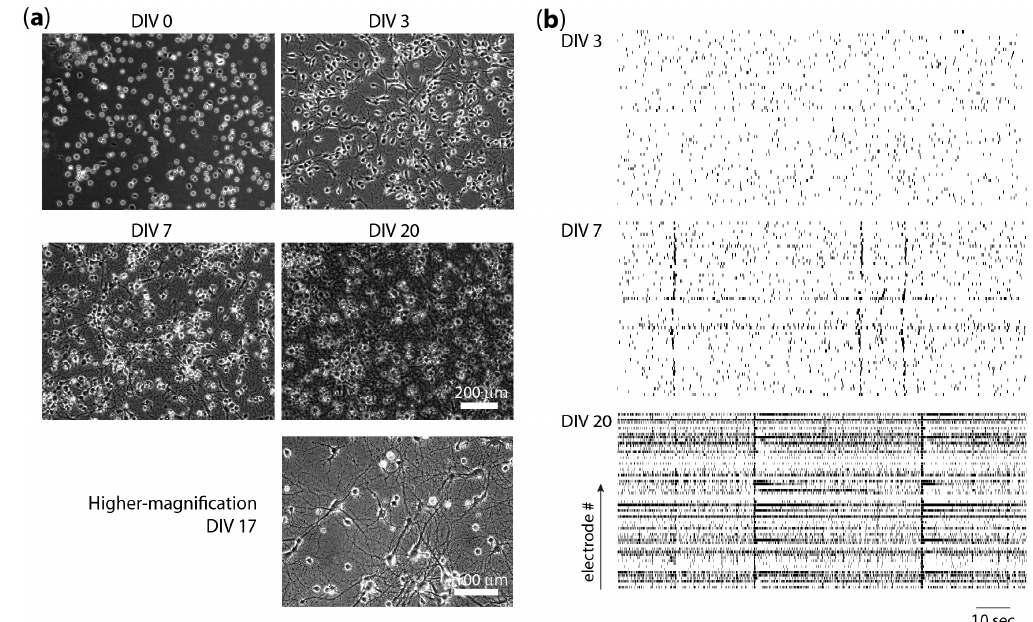
Figure 1. Randomly connected cultures ( a ) Phase micrographs of dissociated neuron cultures on day in vitro (DIV) 0, 3, 7, and 20 (scale bar = 200 µm), and a higher-magnification micrograph on DIV 17 (scale bar = 100 µm); ( b ) Spontaneous neural activity in dissociated neural cultures on DIV 3, 7, and 20. Raster plots were constructed from data published by Wagenaar et al., 2006 [6]. Each plot represents 2 min of activity recorded by 60 electrodes (vertical axis). Network-wide bursts of action potentials occurred on DIV 7 and 20.